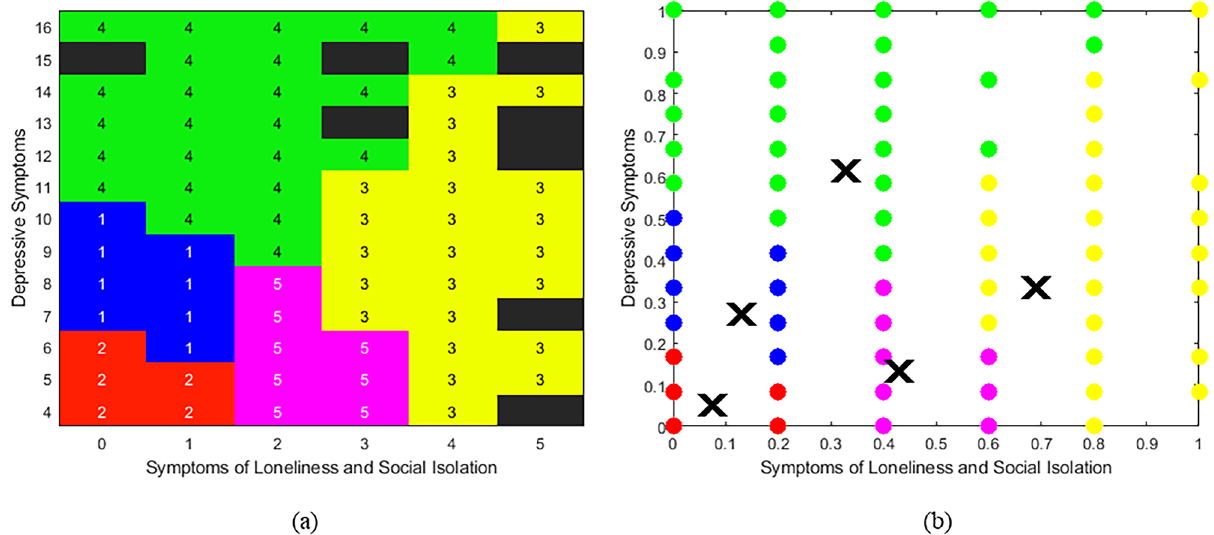
Figure 2. ( a ) Heat Map and ( b ) Scatter plot of the distribution of sub-groups of individuals with CBP based on symptoms of depression and loneliness/social isolation. Data are at discrete intervals due to outcomes being questionnaire based. Data is presented on ( a ) normal item range and ( b ) normalised scale of 0–1. Higher scores indicate greater symptoms of depression or loneliness/social isolation. Based on the centroids of fuzzy c-means clustering, classes and colours are (1; blue) low social isolation and loneliness and moderate depressive symptoms (n = 776; 18.7%), (2; red) low loneliness/social isolation and depressive symptoms (n = 2296; 55.3%), (3; yellow) high loneliness/social isolation and moderate depressive symptoms (n = 185; 4.5%), (4; green) moderate loneliness/social isolation and high depressive symptoms (n = 297; 7.2%) and (5; pink) moderate loneliness/social isolation and low depressive symptoms (n = 602; 14.5%). Black squares on the heat map indicate no class was available at those values. The X value on the scatter plot indicates the centroid of that